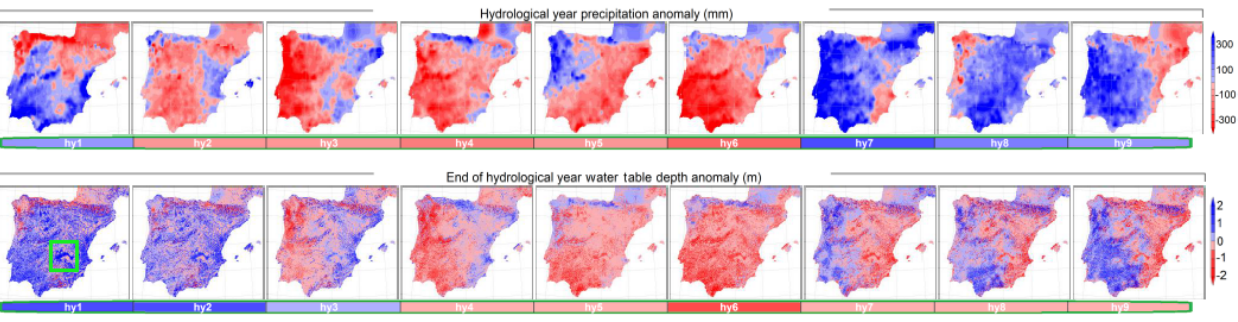
Figure 11. Hydrological year anomaly plots. Each column corresponds to a complete hydrological year (hy1 to hy9). Top row: total yearly precipitation anomalies (mm). Bottom row: end of hydrological year (1 September) wtd anomalies (m). Colour bars below each plot represent the averaged anomaly value for the Iberian